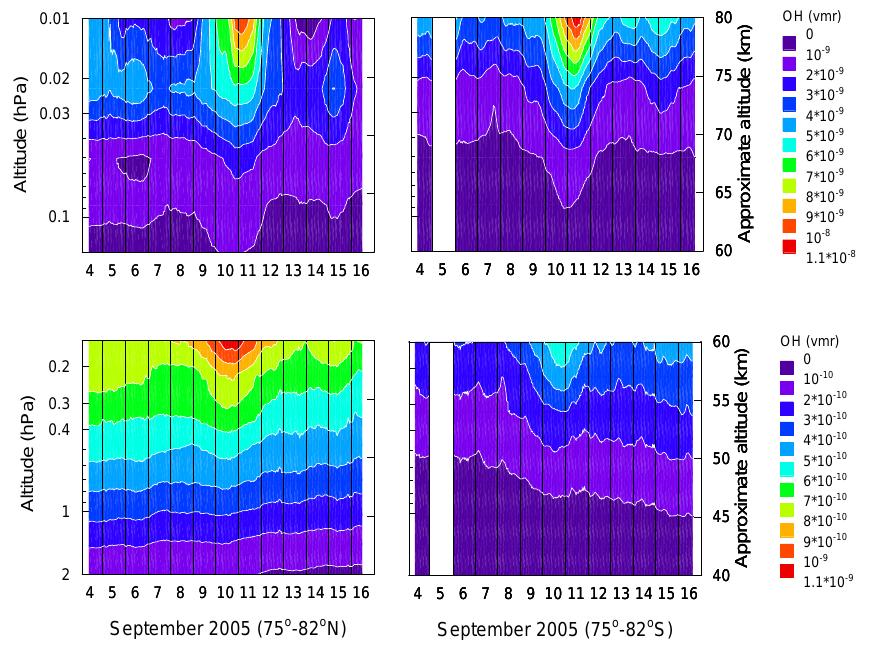
Fig. 5. Temporal evolution of averaged values ( ∼ 75 ◦ –82 ◦ N and S) of September 2005 OH volume mixing ratio (vmr), approximately in mesosphere (top) and in upper stratosphere (bottom). The left column reports the Northern Hemisphere and the right the Southern one (see the caption of Fig. 2 for the correspondent